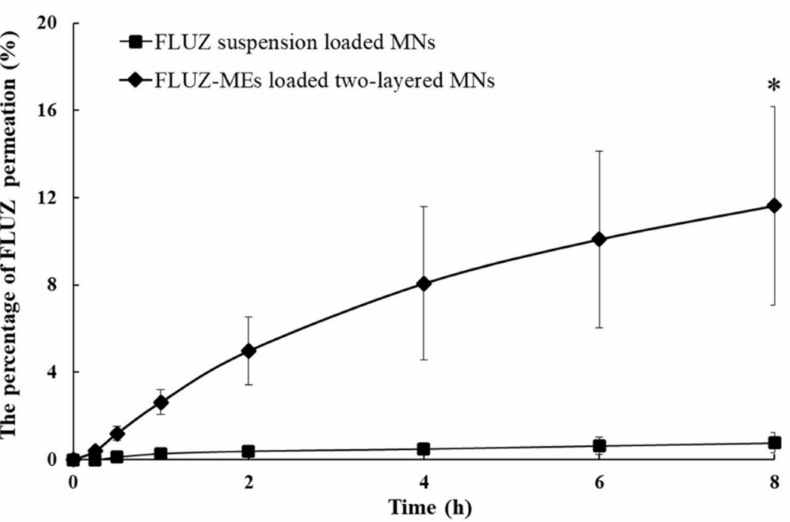
Figure 9. Ex vivo ocular drug delivery of FLUZ-MEs-loaded two-layered dissolving MNs compared with FLUZ-suspension-loaded MNs. * indicates significantly higher than other formulations ( p <